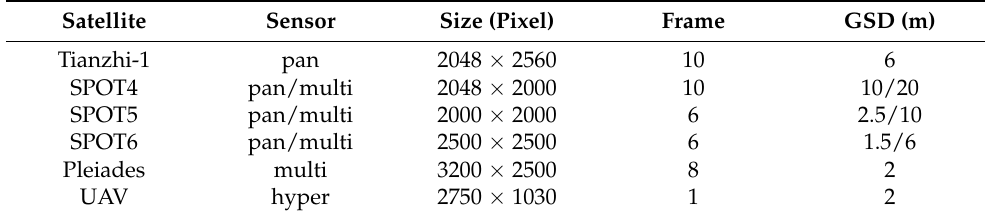
Table 1. The basic information of plain images.